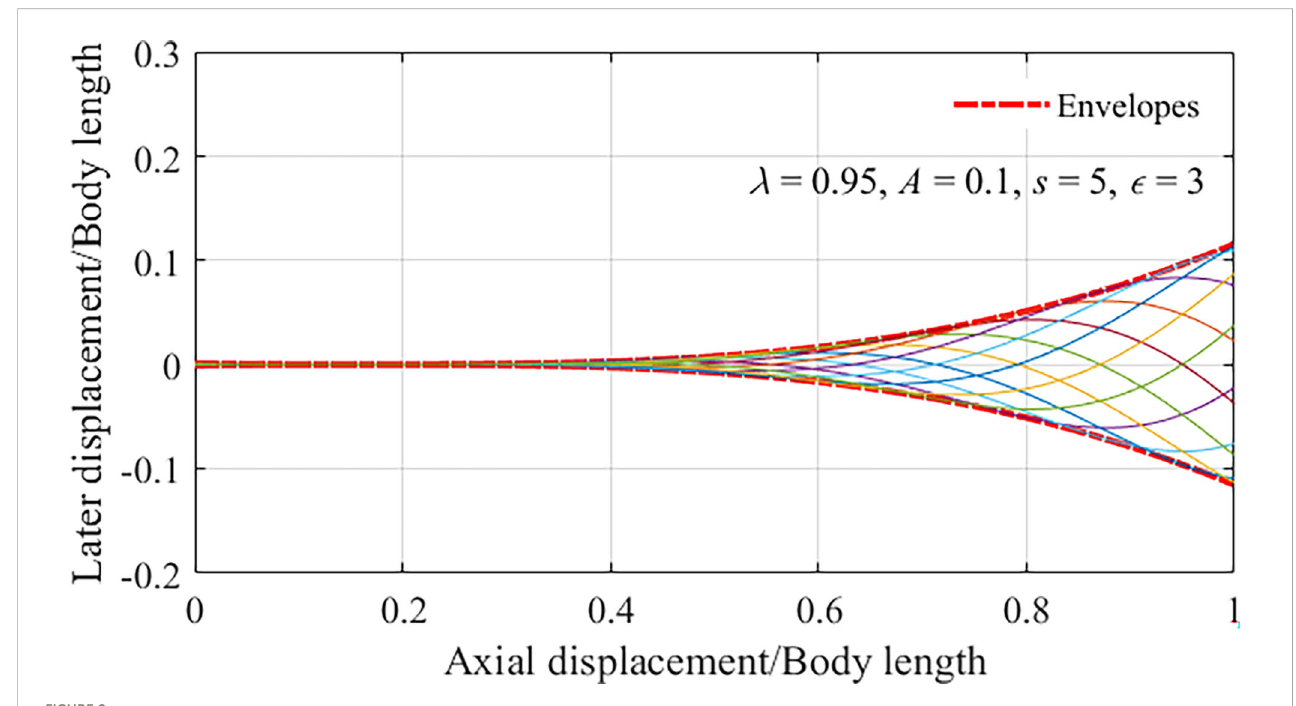
FIGURE 2 Midlines of the fi sh for different instants in one tail-beat